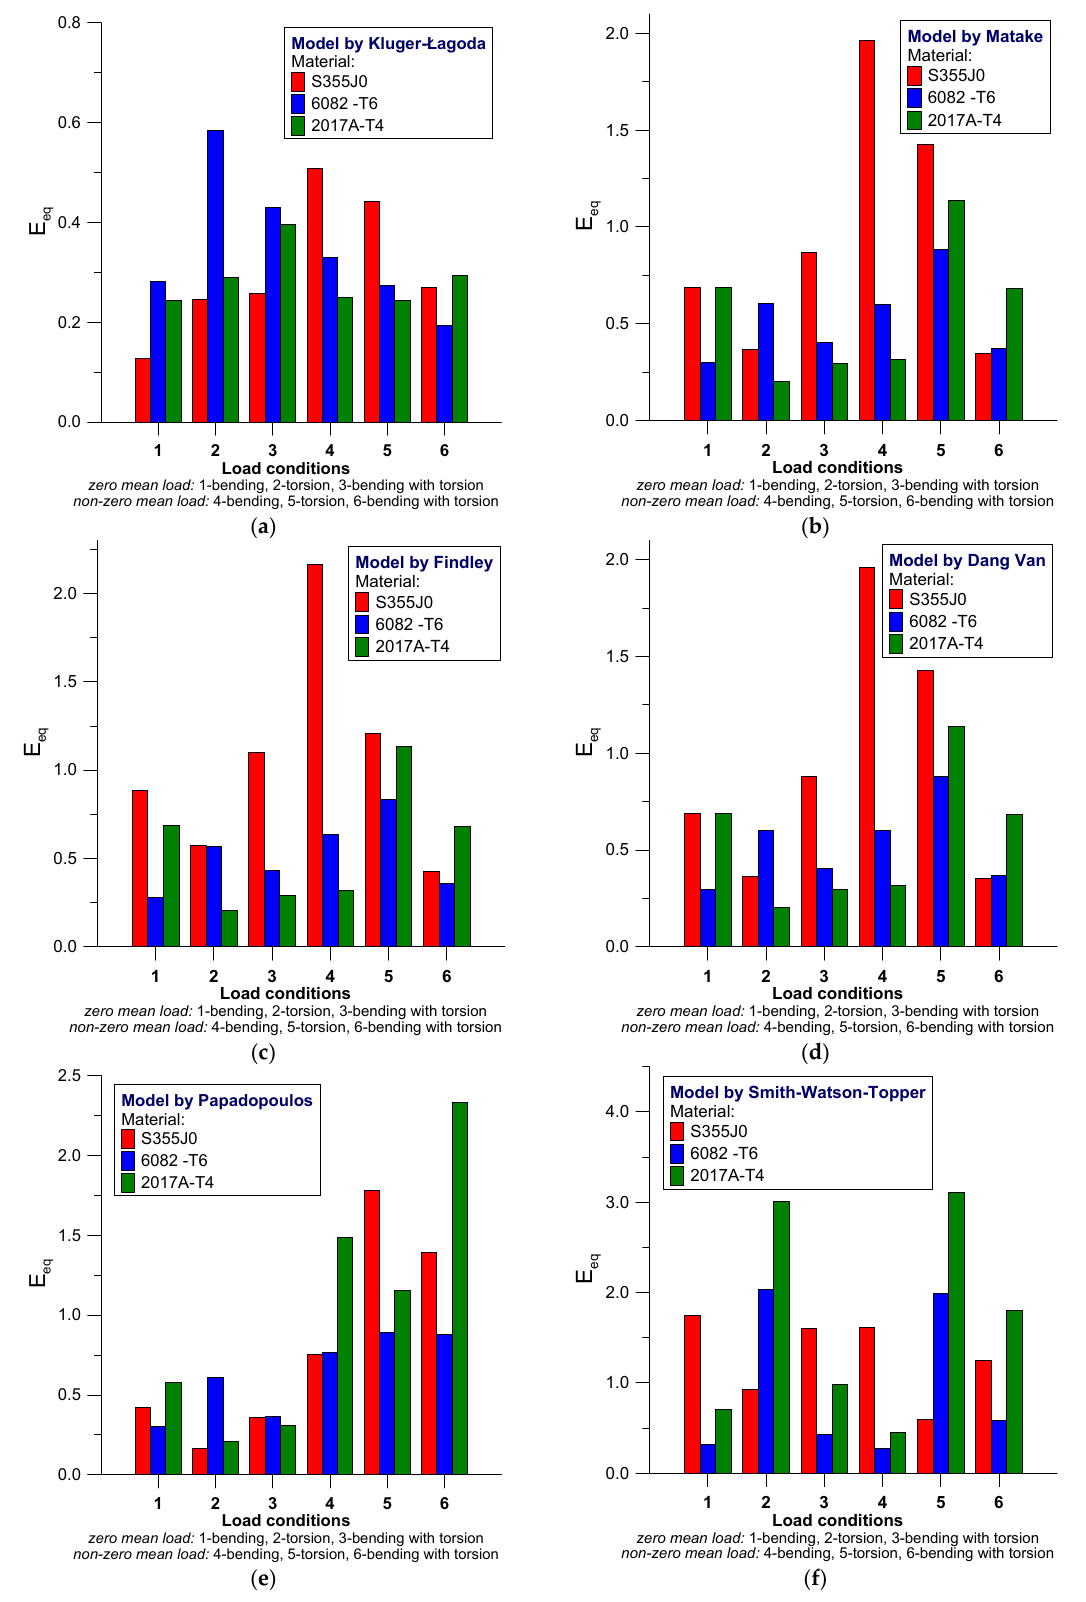
Figure 4. Scatter bands E eq for the analyzed models corresponding to tested materials. ( a ) Kluger-Lagoda; ( b ) Matake; ( c ) Findley; ( d ) Dang Van; ( e ) Papadopoulos; ( f )